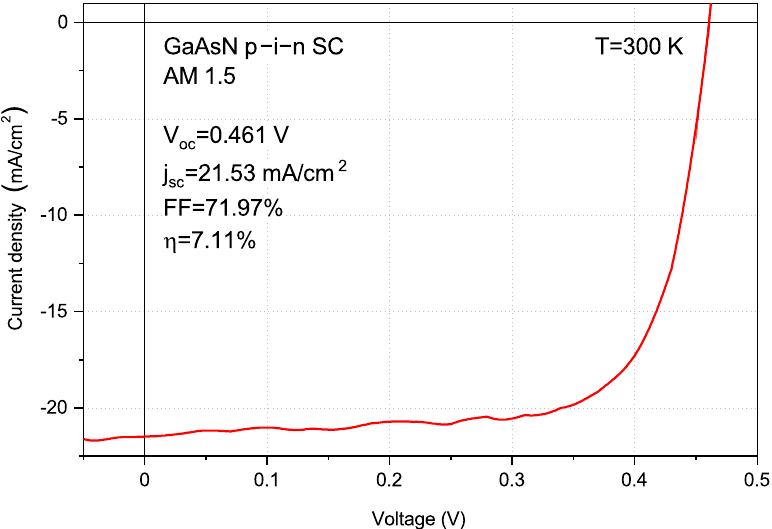
Figure 4. Typical J-V characteristic of the test GaAsN p-i-n solar cell with determined basic parameters.